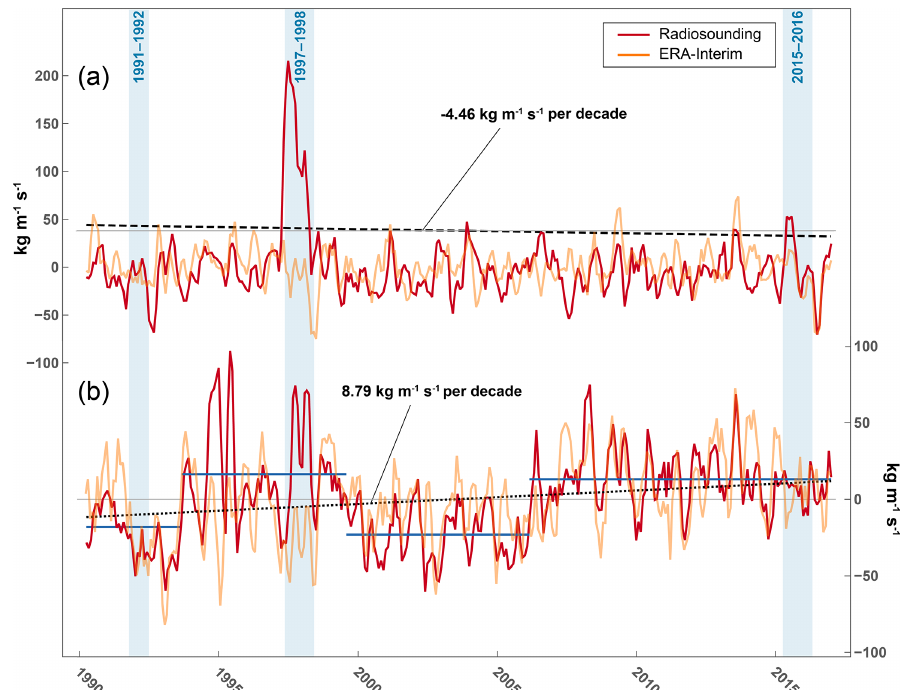
Figure 2. Monthly WVF anomalies in Puerto Montt (a) and Punta Arenas (b) . Shown are the running 3-month mean WVF anomalies for the atmospheric soundings and the nearest ERA-Interim grid point from 1990 to 2016. The blue shaded areas indicate very strong El Niño events (ONI > 1 . 5). The horizontal blue lines in panel (b) show the mean WVF over water-vapour-rich and water-vapour-poor